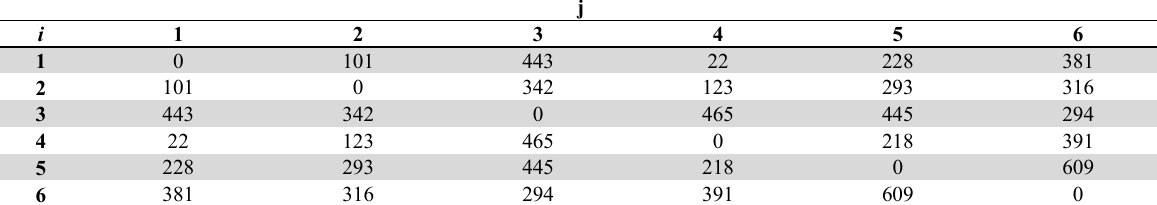
Distances without